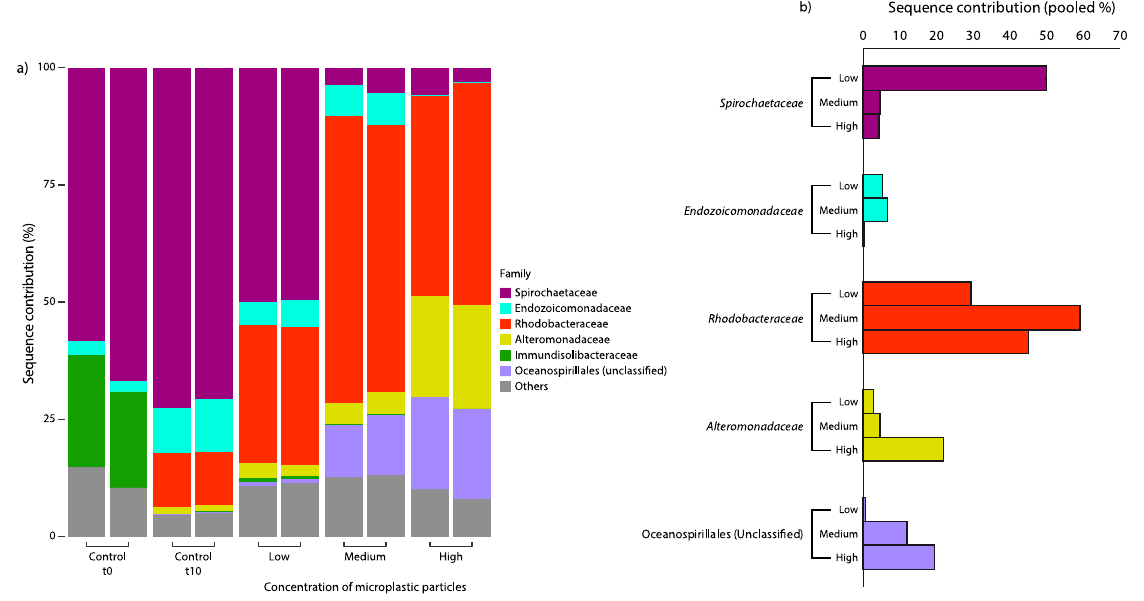
Fig. 6 Coral microbiomes at the beginning (Control t0) and after 10 days of experiment (Control t10), and in corals exposed to different concentrations of microplastic particles. a Taxonomic composition of microbial assemblages; b pooled sequence contribution of relevant families to the taxonomic composition: ubiquitous Spirochaetaceae associated with the healthy Mediterranean red corals 57 ; Alteromonadaceae , Endozoicomonadaceae , Rhodobacteraceae and Oceanospirillaceae typically associated with stressed and diseased corals 57,63